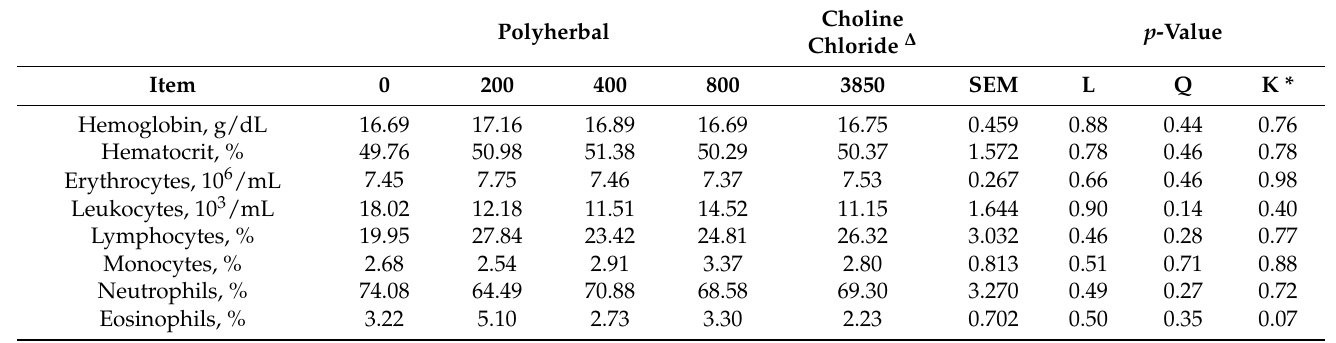
Table 3. Effect of the polyherbal level and choline chloride supplementation (mg/kg) on the blood count of